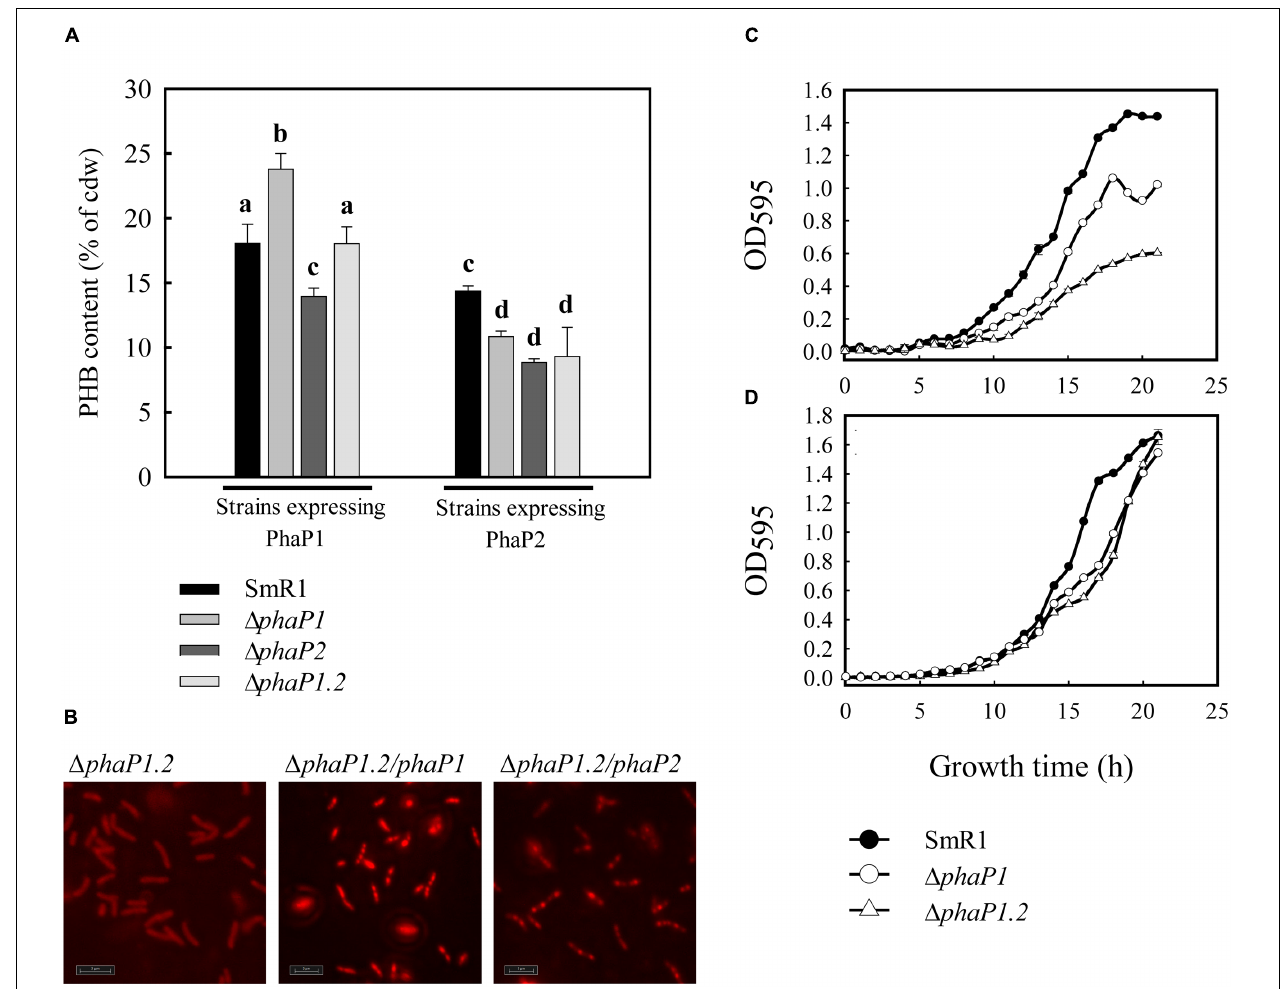
FIGURE 5 | Poly-3-hydroxybutyrate contents of phaP mutants complemented with plasmids harboring phaP1 and phaP2 . (A) H . seropedicae strains conjugated with pLPA01 were complemented with phaP 1 in trans under control of its native promoter. The strains conjugated with pLPA02 were complemented with phaP 2 in trans under control of its native promoter. Cells harboring pLPA01 or pLPA02 were grown in liquid NFb containing 37 mM DL -malate and 20 mM NH 4 Cl at 30 ◦ C. When the OD 600 of the cultures reached 1.0, 10 mL was removed to determine the PHB content by gas chromatography as described in section “Materials and Methods.” The bars marked with different letters indicate means significantly different (independent two-sample t -test, p < 0.05). Experiments were performed in quadruplicate. (B) Cells of (cid:49) phaP1.2 mutant complemented with pLPA01 were stained with Nile Red and visualized by excitation with 543 nm light. Strains harboring pBBR1MCS-3 (C) or pLPA01 (D) were grown in NFb medium with 20 mM of ammonium chloride and 25 mM (w/v) D -glucose at 30 ◦ C (orbital agitation at 120 rpm). OD 595 growth data were obtained from three independent